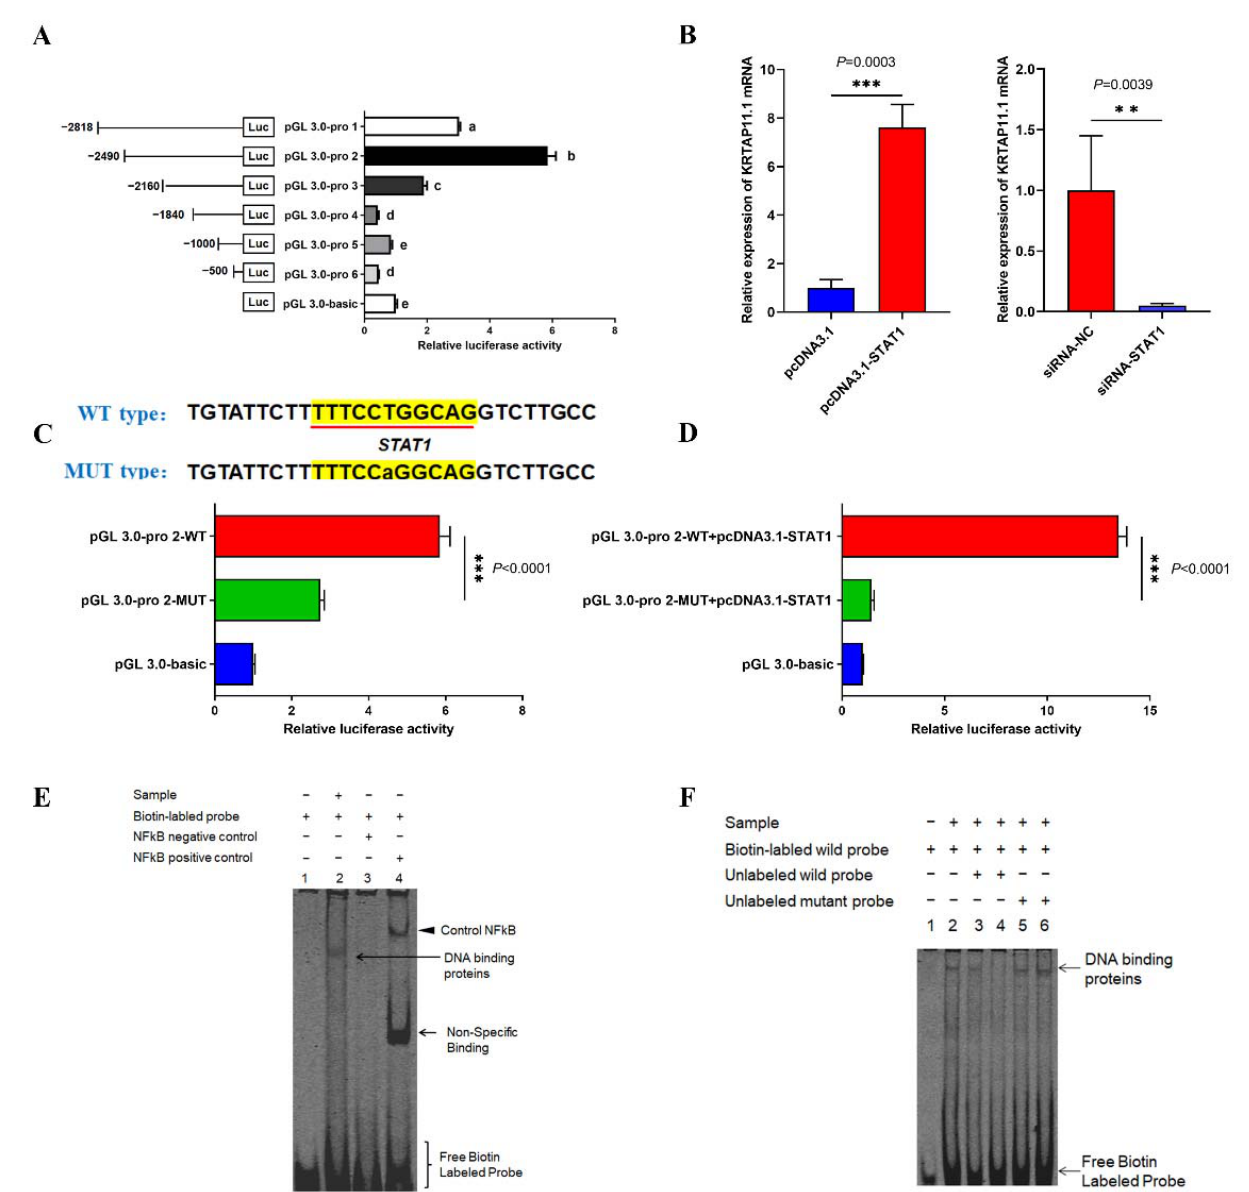
Figure 5. STAT1 regulated KRTAP11-1 transcriptional expression. ( A ) The detection of luciferase activity in the KRTAP11-1 promoter region. ( B ) STAT1 promoted KRTAP11-1 mRNA expression